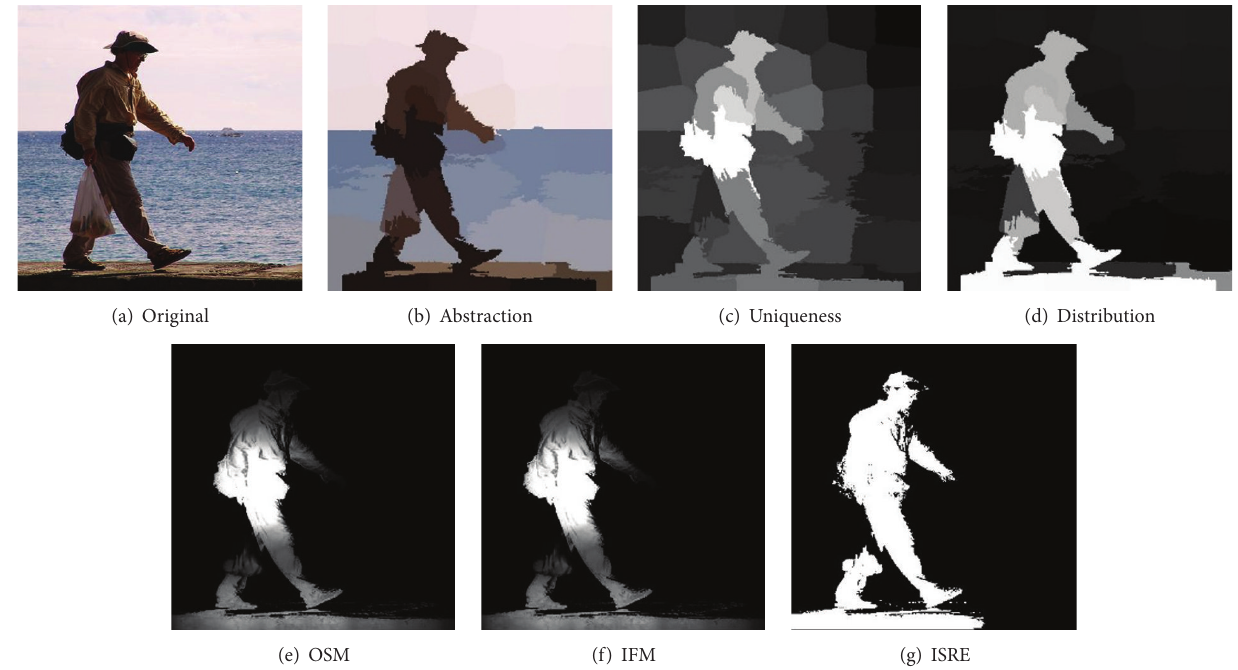
Figure 2: Effect map of units in ISRE